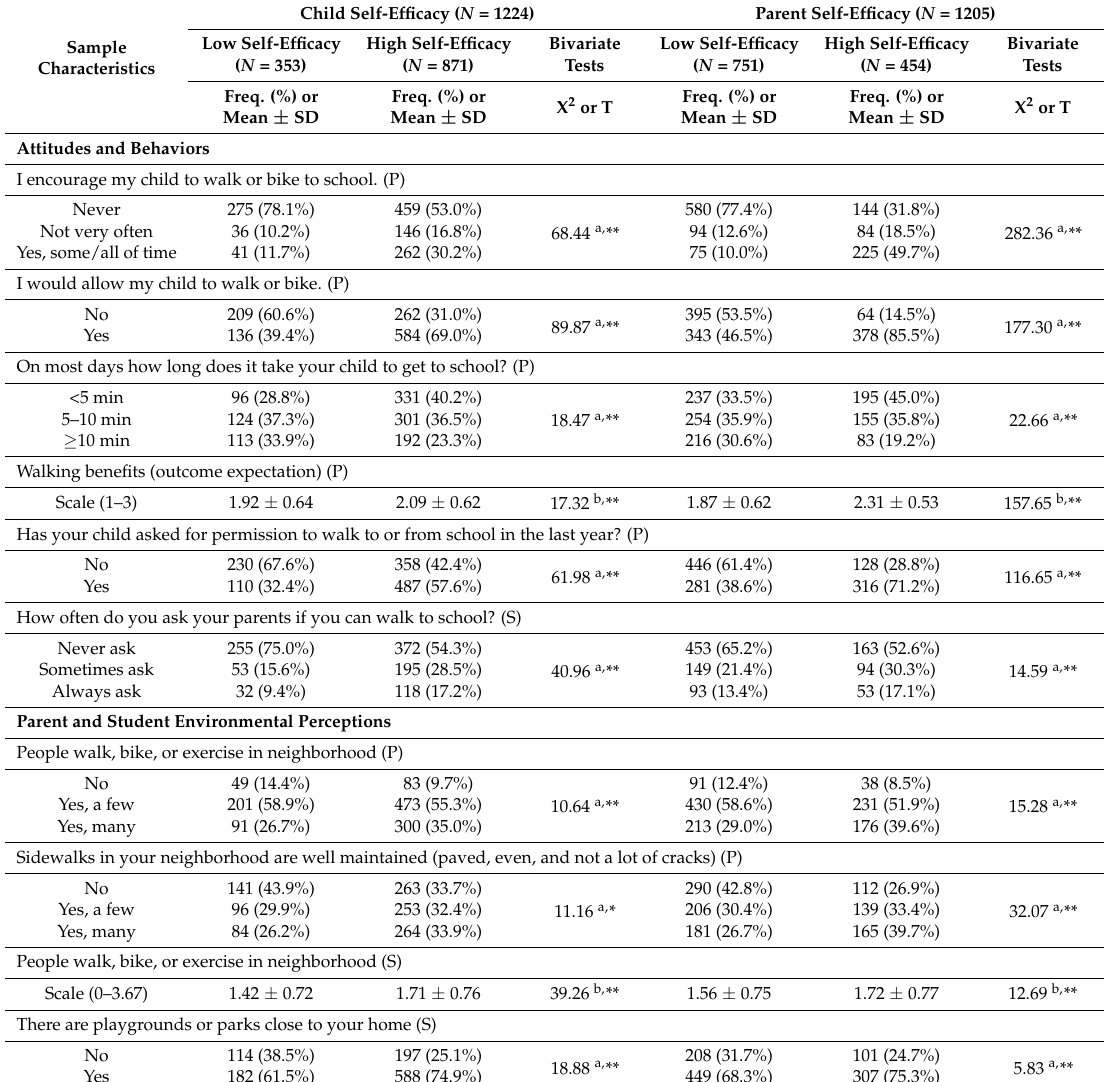
Table 3. Descriptive statistics and bivariate tests for attitudinal, behavioral, and environmental variables.